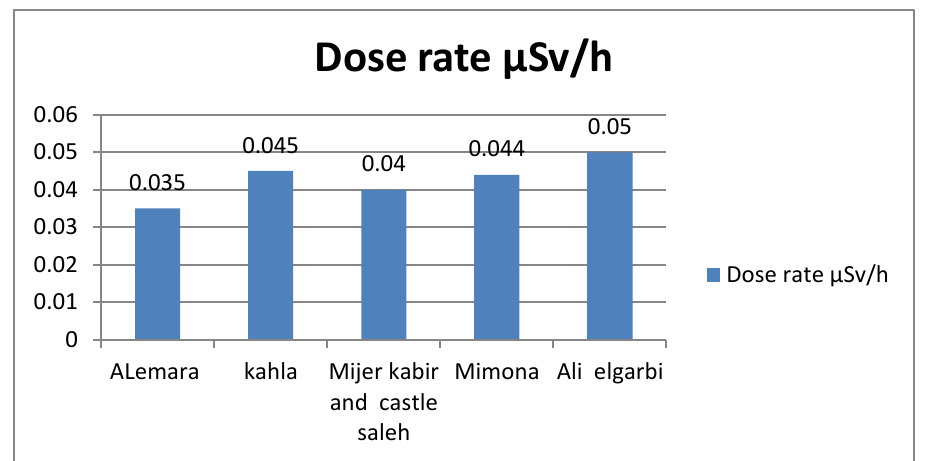
Fig. 7: The radiation dose rates for the elected positions in the province of Missan by the portable device FH-40.